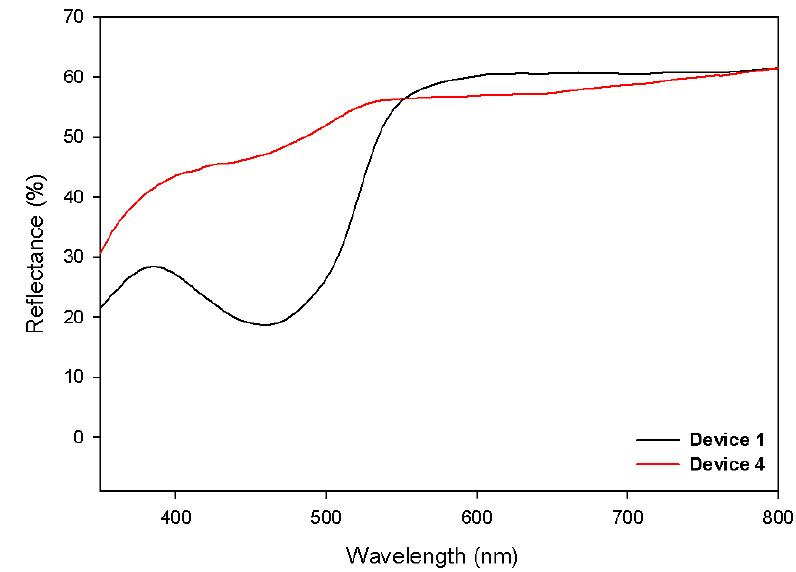
Figure 7. Reflection spectra of Device 1 and Device 4